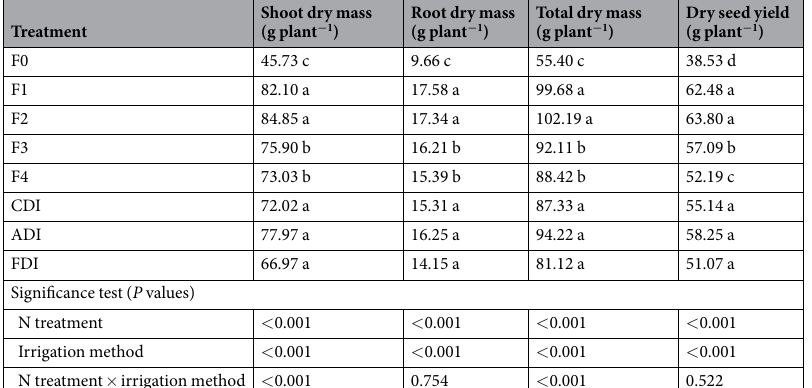
Table 1. Mean dry mass accumulation and dry seed yield of sweet-waxy maize for different irrigation methods and N treatments. Analysis of variance (ANOVA) P values were shown ( P < 0.05, significance; P > 0.05, no significance). Different small letters in the same column are significantly different for various N treatments or irrigation methods ( P < 0.05), and the same letters are not markedly different for various N treatments or irrigation methods ( P > 0.05). F0: no N supplied; F1: 0.2 g N kg − 1 soil; F2: 0.18 g N kg − 1 soil; F3: 0.16 g N kg − 1 FDI: fixed partial root–zone drip irrigation. The symbols in the following Tables are the same as this